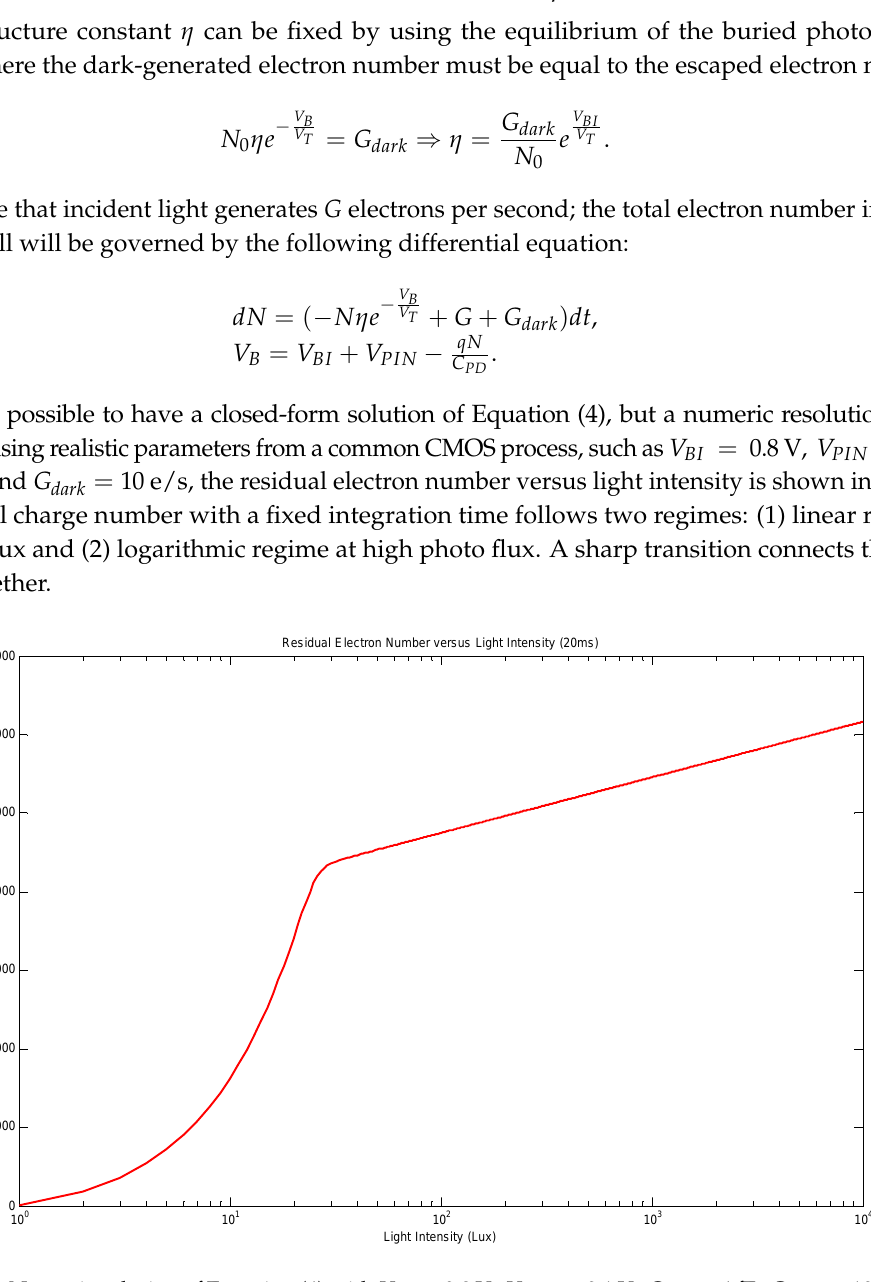
Figure 3. Numeric solution of Equation (4) with V BI = 0.8 V, V PIN = 0.1 V, C PD = 4 fF, G dark = 10 e/s, and T EXP = 20 ms. The transition point calculated from Equation (5) is at 8300 electrons, which fits well with this numeric